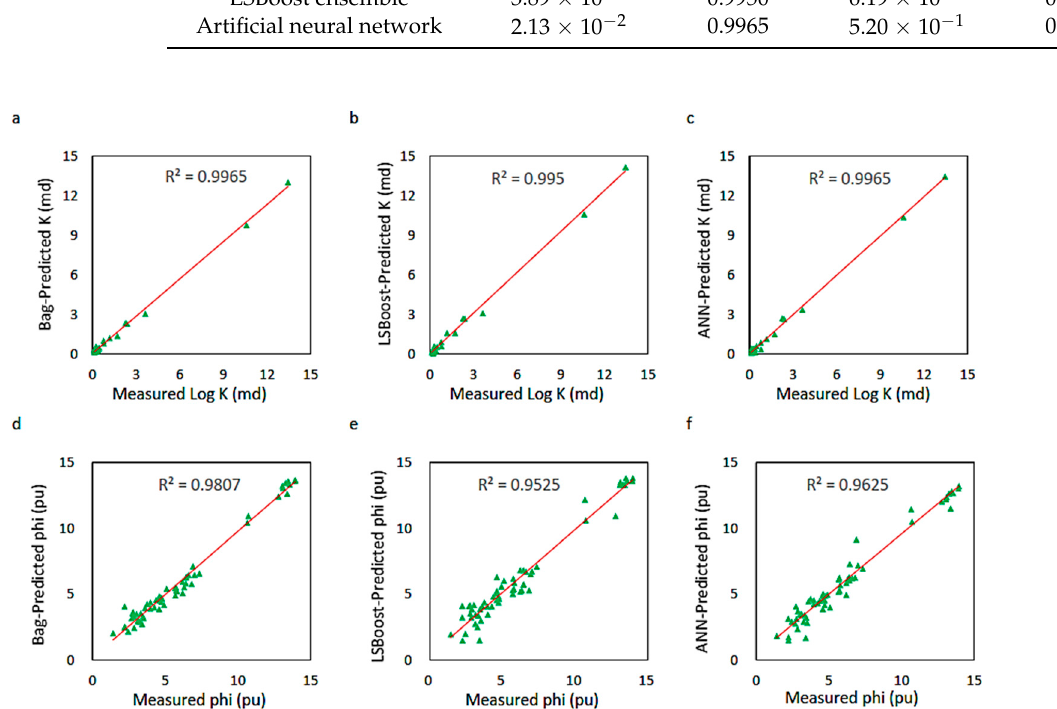
Figure 18. Correlations of the statistically and intelligently estimated permeability ( a – c ), and porosity ( d – f ) with the measured values in the unconventional gas field of the Qinshui Basin of China.